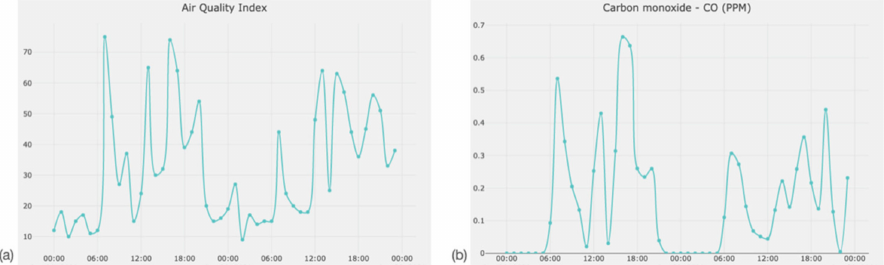
Figure 11. Hourly average in Santo Domingo of ( a ) air quality on 28 and 29 September 2020 and ( b ) carbon monoxide on 2 and 3 January